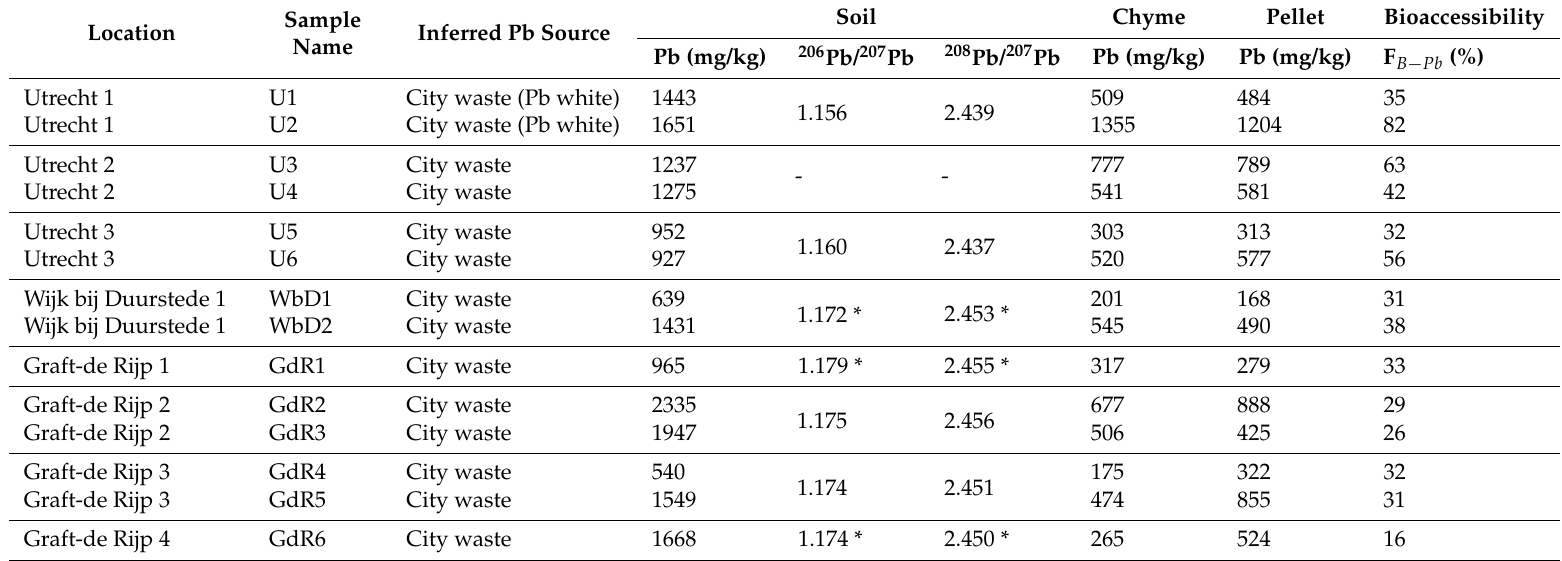
* measured in different soil sample, but from the same sample